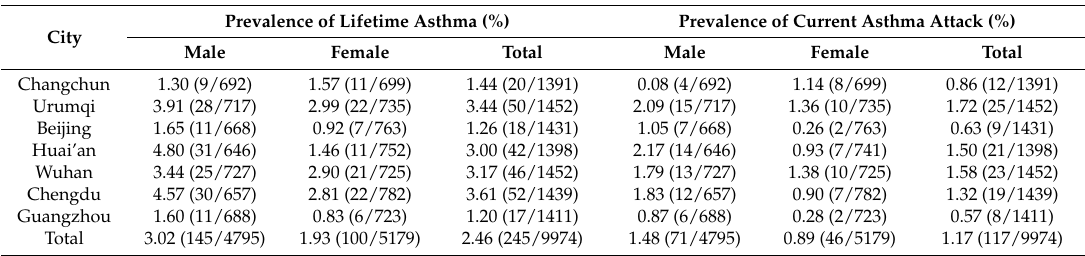
Table 1. Prevalence of asthma in different cities.